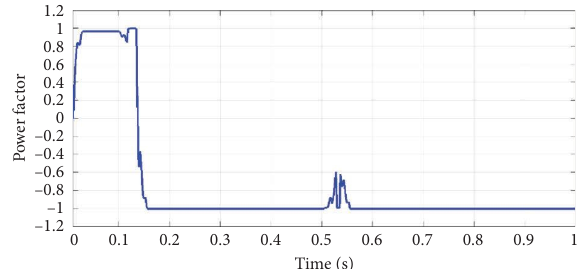
Figure 13: Modulation coefcients of reference.